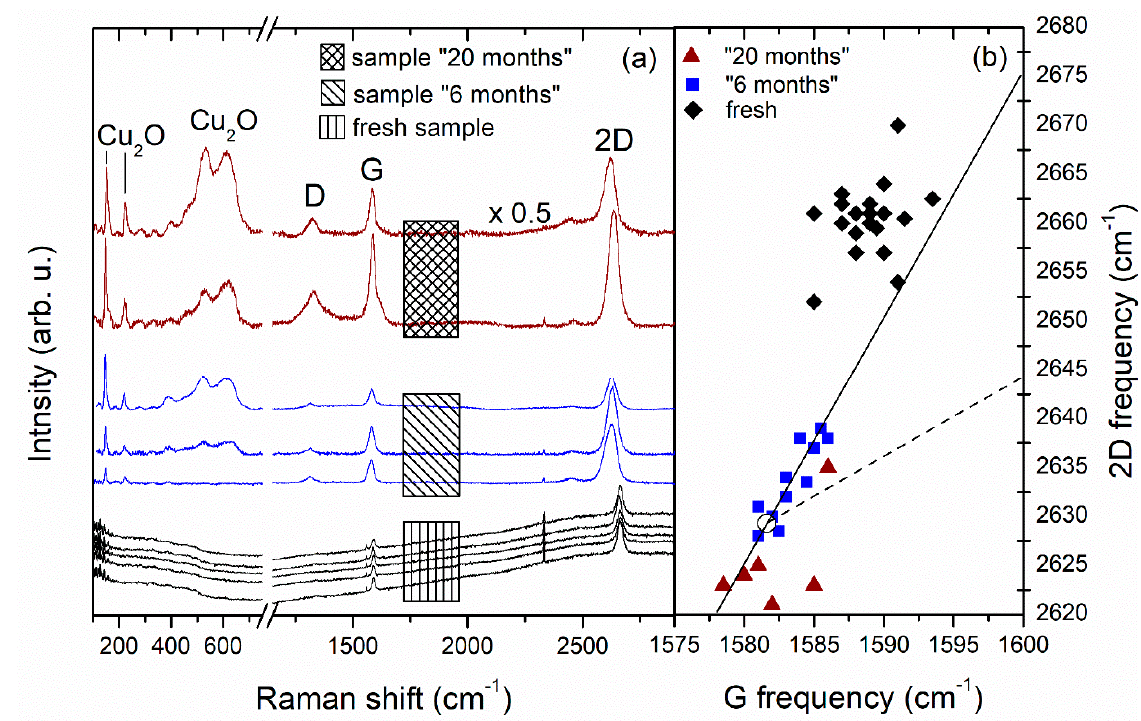
Figure 4. ( a ) Representative Raman spectra from the three investigated samples. Traces for samples “6 months” (blue) and “20 months” (brown) are plotted after background subtraction for clarity. Vibrational bands originating from graphene and Cu 2 O are indicated. ( b ) A 2D versus G frequency plot with data extracted from the spectra of the three investigated samples. Each point represents a ( ω G , ω 2D ) pair from a distinct spectrum from sample: “fresh” (black diamonds), “6 months” (blue squares) and “20 months” (brown triangles). The straight solid line corresponds to a purely strain-induced shift, the empty circle to the zero-strain point and the dashed line to a purely doping-induced shift as taken from Figure 4 of Ref. [27].